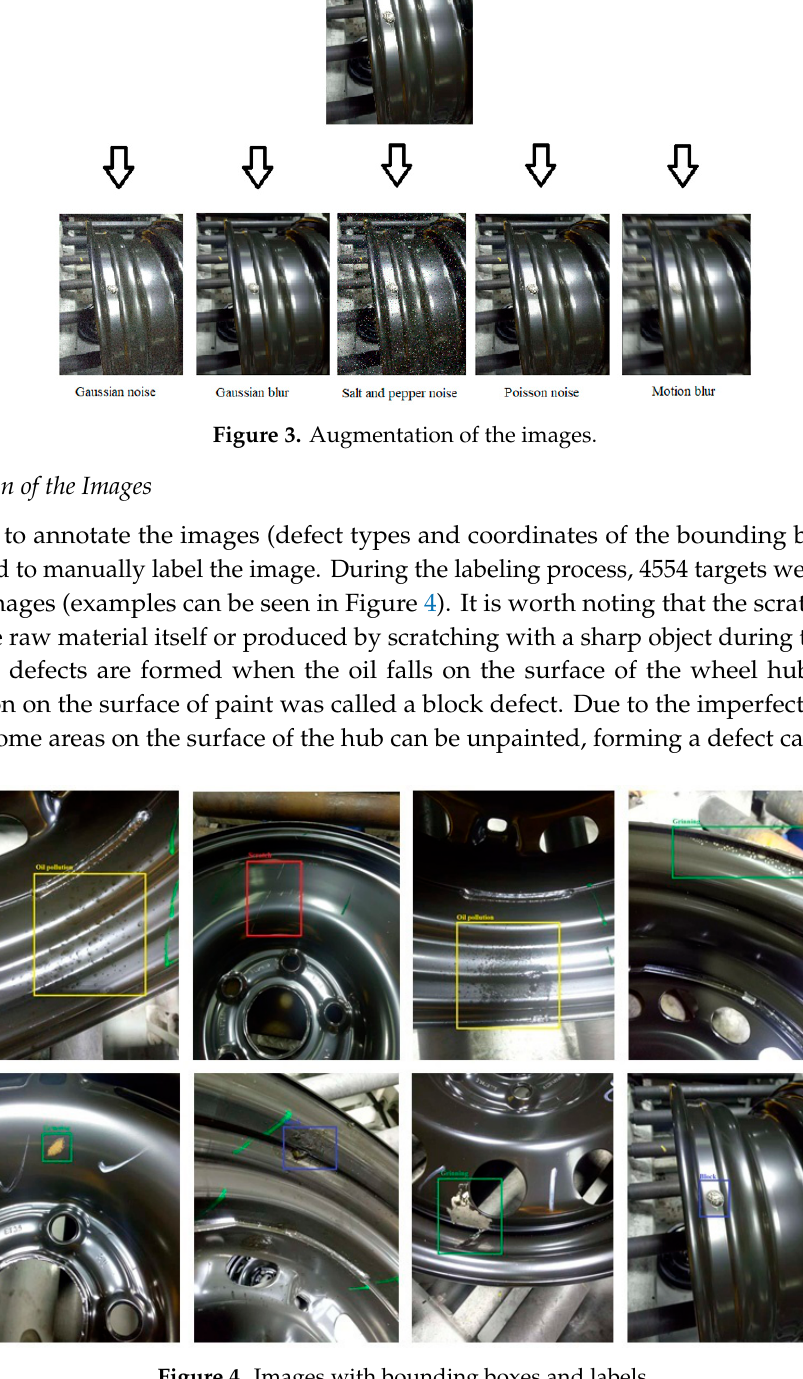
Table 1. The proportion of training, validation, and testing sets. Defect class